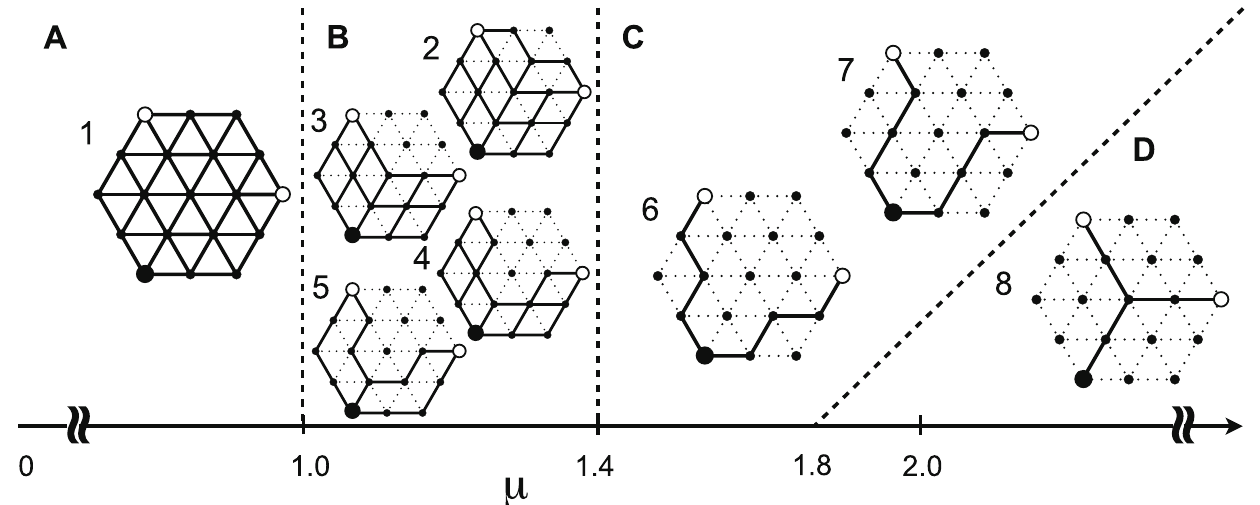
Figure 2. Dependence of network topology under constant input and output. Initial values of D ij were either set as homogeneous ( D ij ~ 1 : 0 for all links) or were distributed according to a normal distribution with mean 1.0 and standard deviation 0.1. Solid and dashed lines of the network diagrams denote surviving and removed links, respectively. A Complete mesh (type 1), 0 v m v 1 . B Partial mesh (types 2–5), 1 ƒ m 1 : 4 . C V- shaped network (types 6 and 7), m 1 : 4 . D Y-shaped network (type 8), m 1 : 8 . When the initial conditions of D ij are exactly homogeneous, the V- shaped network appears in the range of 1 : 4 m 2 : 2 and the Y-shaped network appears in the range of m 2 : 3 . Type numbers correspond to those of Figs. 3 and S1.